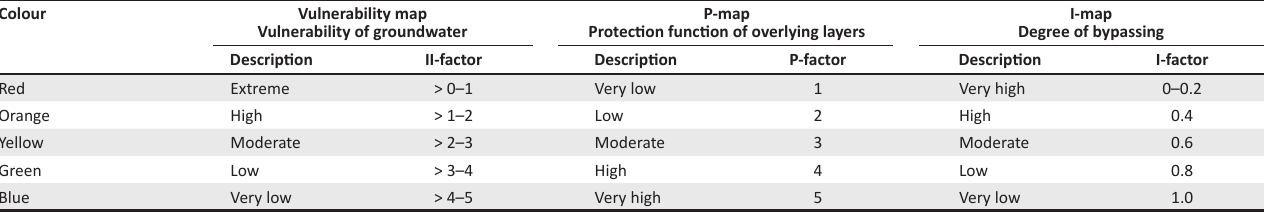
TABLE 6: Index of vulnerability map derived from P-factor, I-factor and PI vulnerability map. Colour